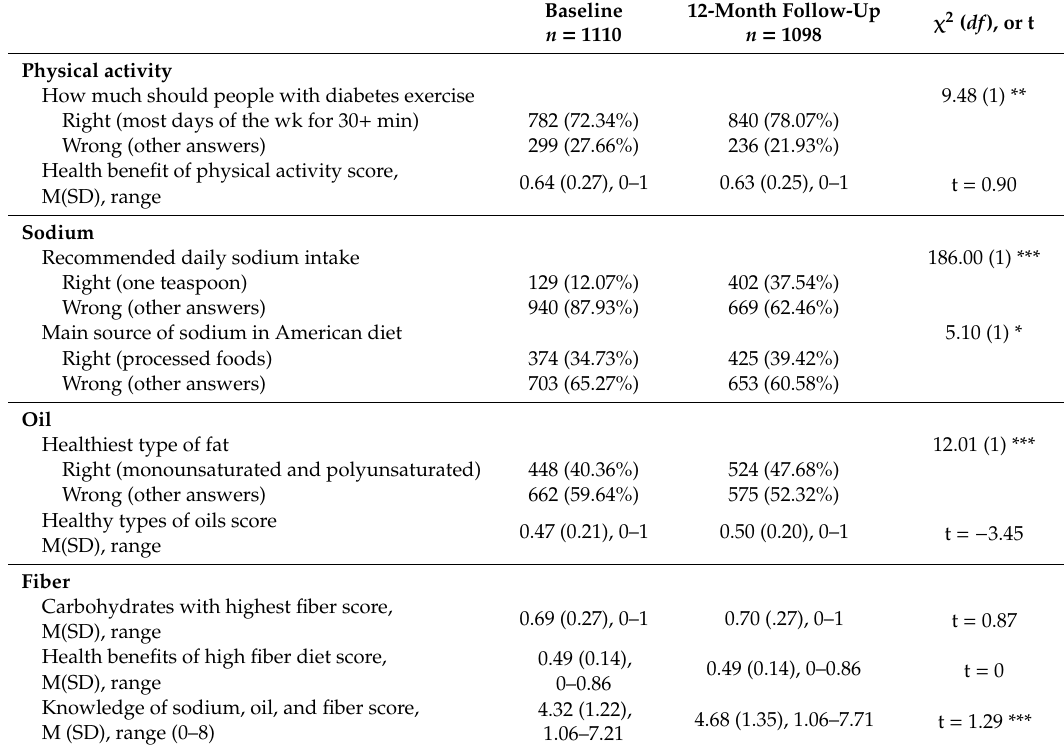
Table 3. Knowledge of Nutrition and Health E ff ects Related to Sodium, Oil, and